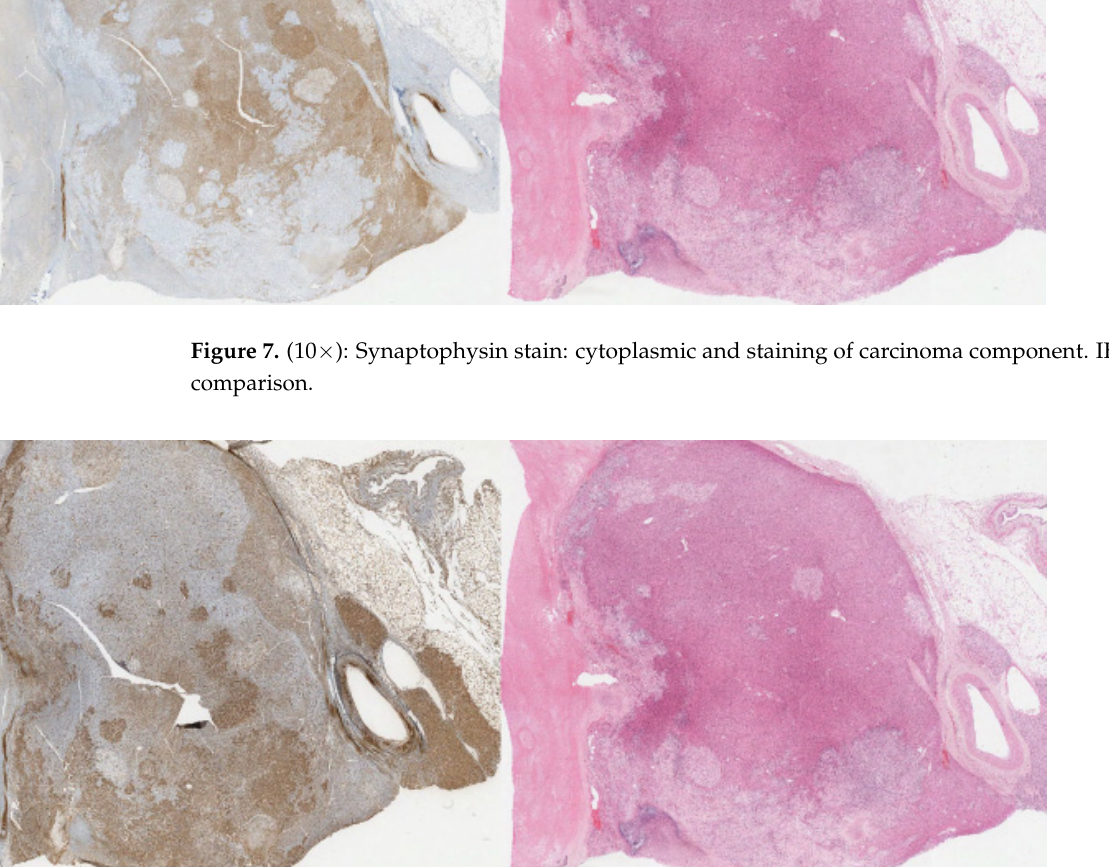
Figure 8. (10x): Vimentin stain: strongly positive sarcomatous component. IHC for comparison.